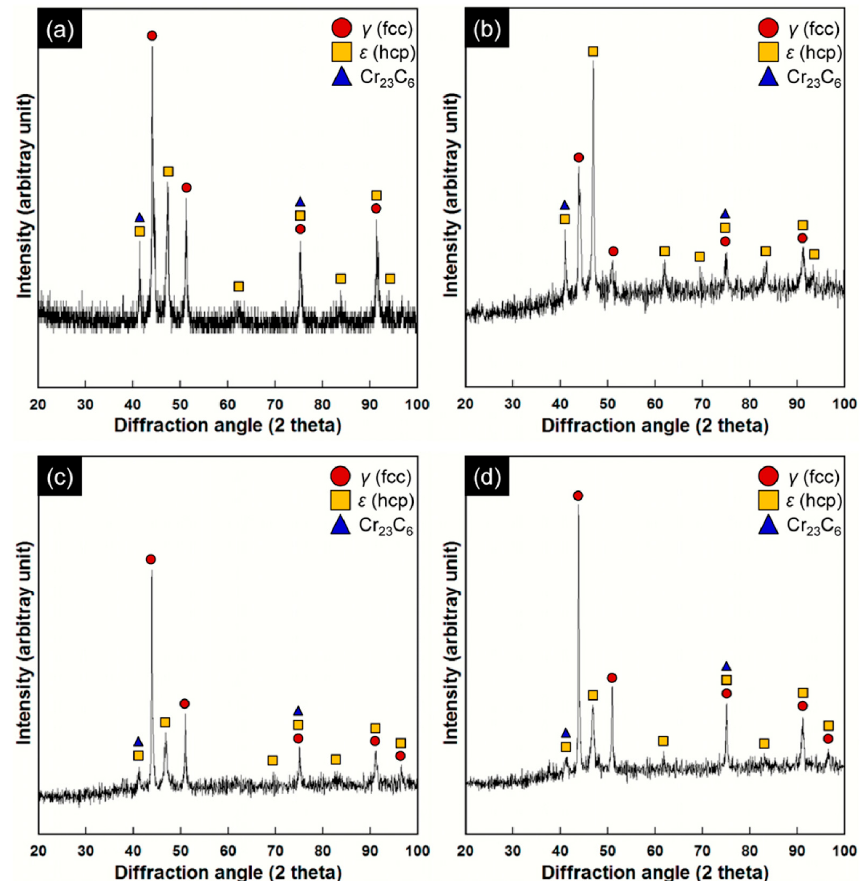
Figure 1. XRD patterns of the Co–Cr alloys in the as-pre-sintered state ( a ) and in the post-sintered states (prepared at three different temperatures) : ( b ) 1250 °C; ( c ) 1350 °C; ( d ) 1450 °C. The Co-based γ (face-centered cubic, fcc) and ε (hexagonal close-packed, hcp) matrix phases were identified with JCPDS cards no. 15-806 and no. 05-727, respectively. The peaks indexed as Cr 23 C 6 metal carbides were identified by JCPDS card no. 35-783.